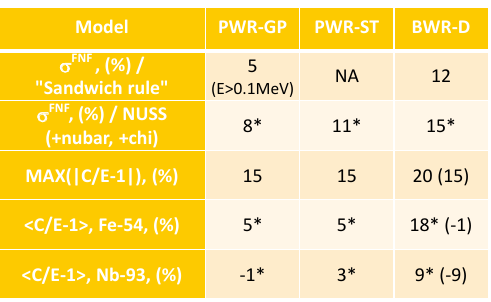
Table 1. Summary on the obtained C / E and UQ